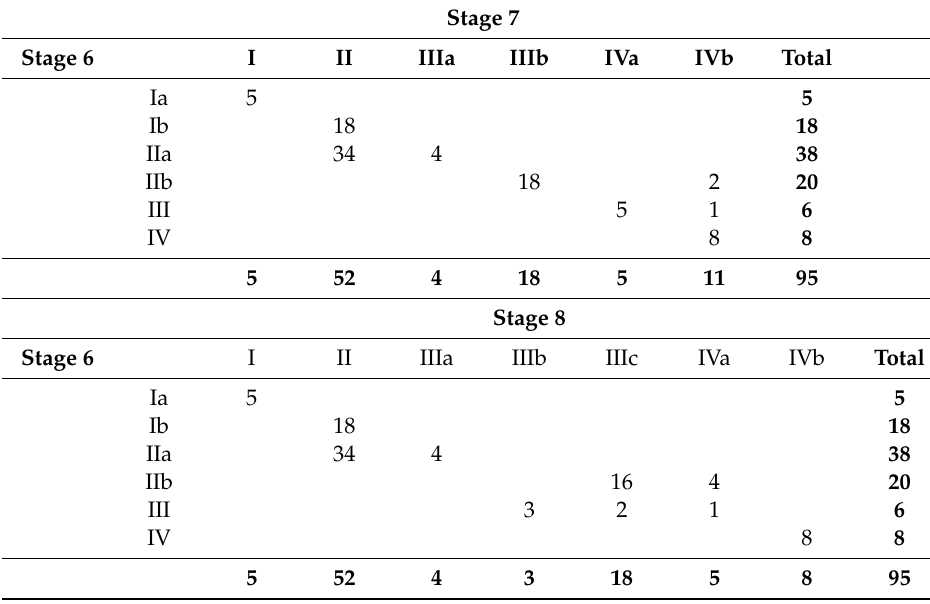
Table 3. Cross-tabulation of the 6th, 7th, and 8th editions of the American Joint Committee on Cancer (AJCC) staging